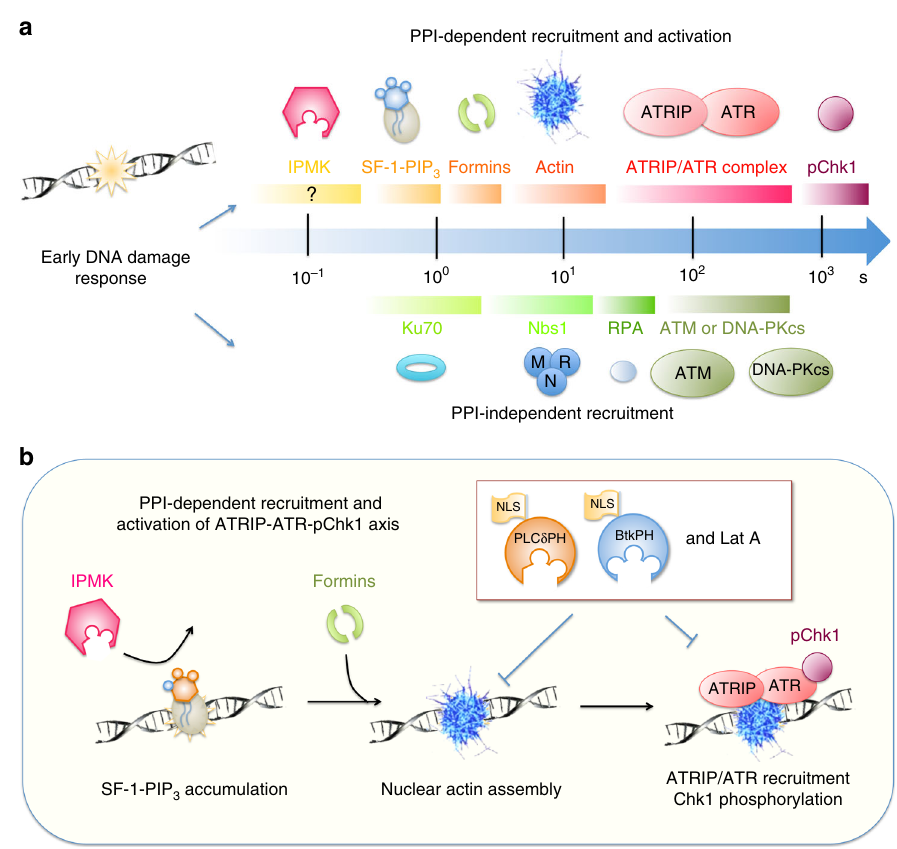
Fig. 7 Schematic illustration of proposed model for PPI- and nuclear actin-dependent ATR-ATRIP-pChk1 signaling axis. a Proteins that are recruited to the damage site along the time line are grouped into two categories by whether or not their recruitment or activation depends upon nuclear PPIs. b Schematic presentation of proposed model for PPIs- and actin-dependent recruitment and activation of ATR-ATRIP